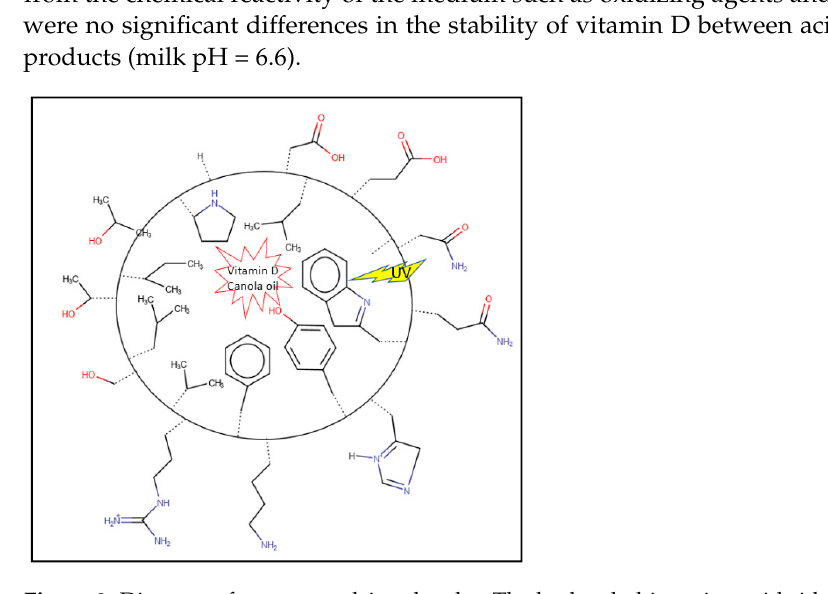
Figure 3. Diagram of a nanoemulsion droplet. The hydrophobic amino acid side chains are facing inside and interacting with vitamin D and canola oil, while the hydrophilic amino acids are exposing outside interactions with water. The aromatic amino acids and conjugated backbones are absorbing the UV and protecting the vitamin D. Table 6 . Vitamin D content (µg/100 mL) in all food products over 24 h.